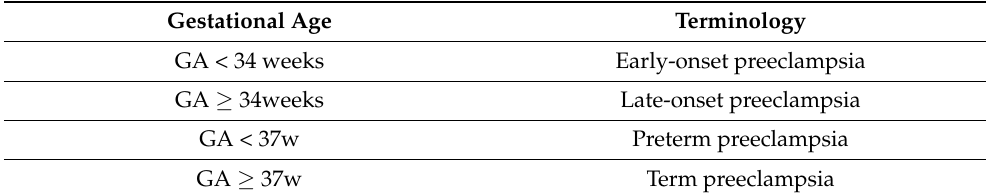
Table 1. Classification of preeclampsia according to gestational age.